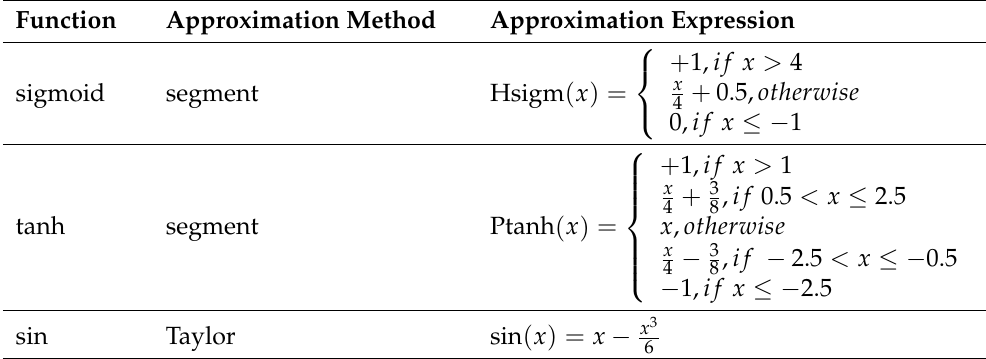
Table 2. Approximation